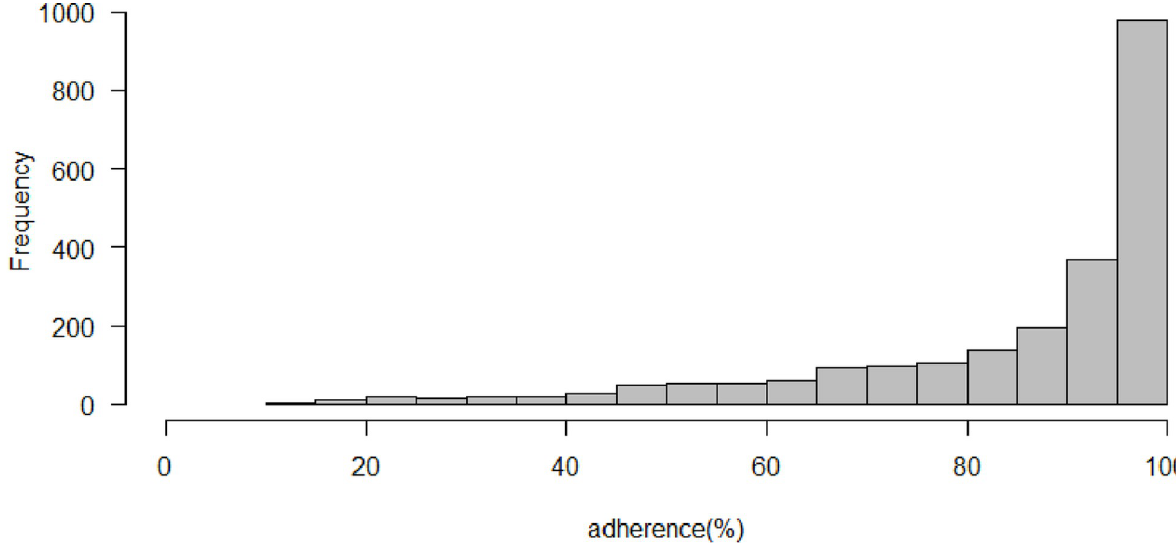
Fig 1. Distribution of average adherence per patient in the KPNC cohort. Average adherence was the average over all of each patient’s 6-month intervals during follow-up.